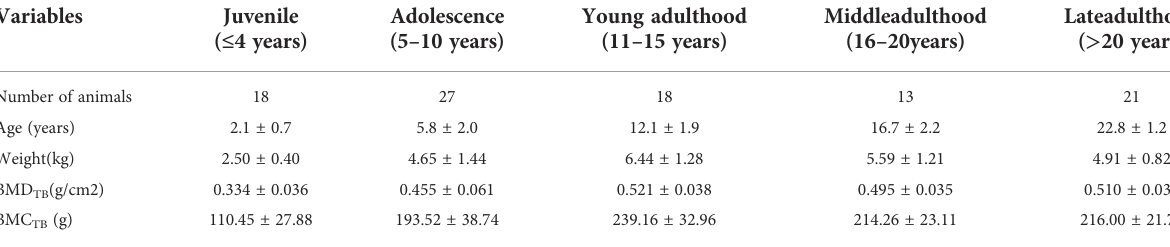
TABLE 1 Descriptive characteristics of female cynomolgus